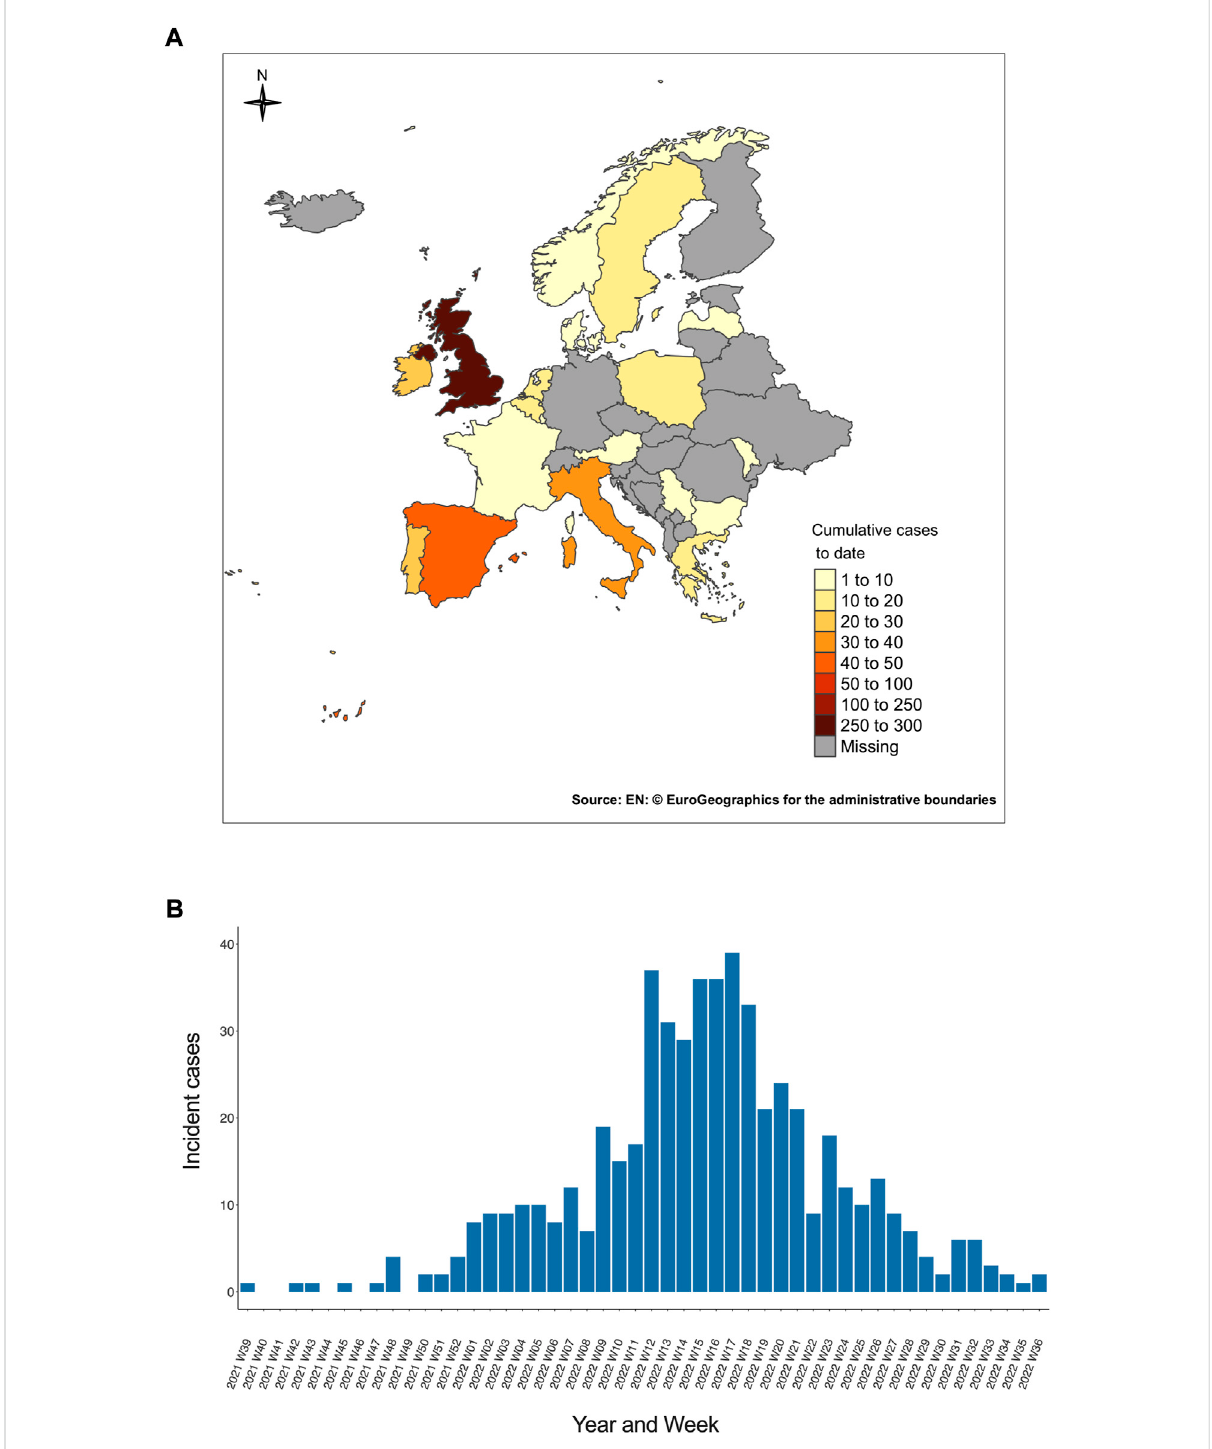
FIGURE 2 Epidemiology of AS-Hep-UA in Europe. (A) Number of cumulative AS-Hep-UA cases reported in European countries by the European Centre for Disease Preventionand Control (ECDC) as of25 August 2022. Cumulative casenumbersare presented for countries for which data wasavailable from the ECDC, and labelled as ‘ missing ’ for those for which no data were reported. (B) Number of weekly probable AS-Hep-UA cases of unknown origininEuropeanchildrenreportedbetweenthe39thweekof2021andthe36thweekof2022.Underlyingdataforboth fi gurepanelssourced from European Centre for Disease Prevention and Control (ECDC) (ECDC,